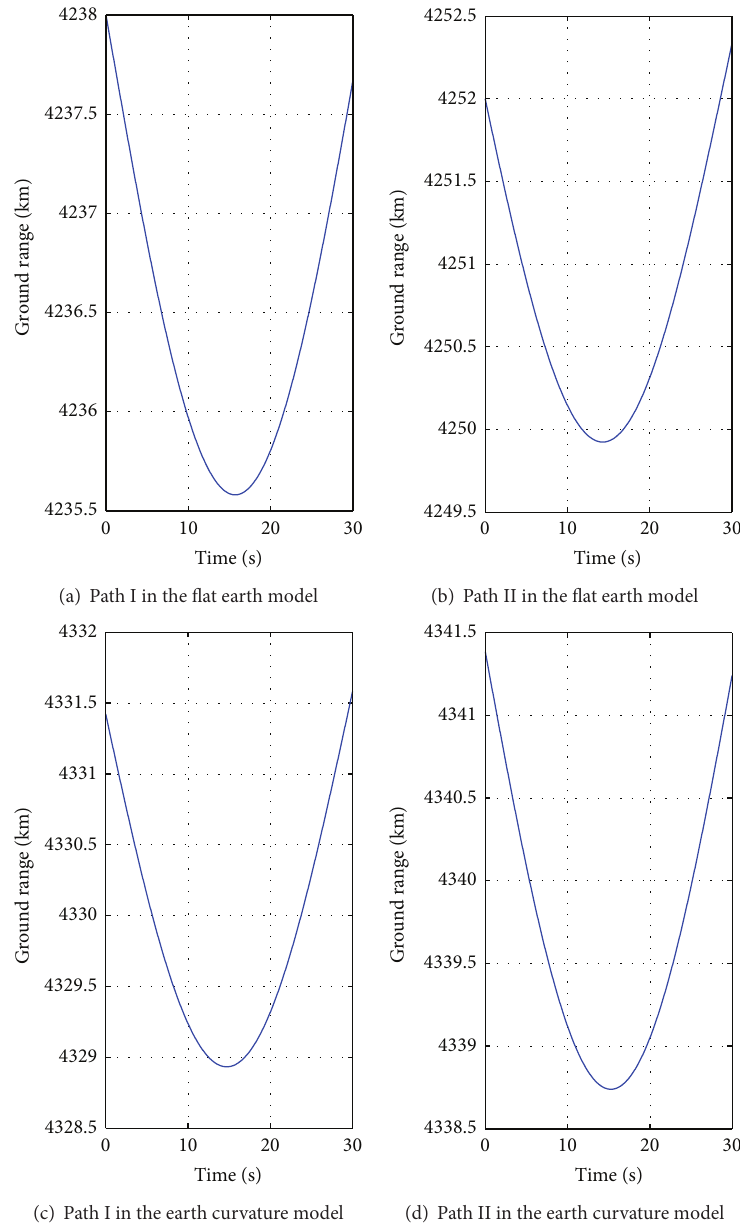
Figure 13: The simulation results of Path I and Path II in two kinds of